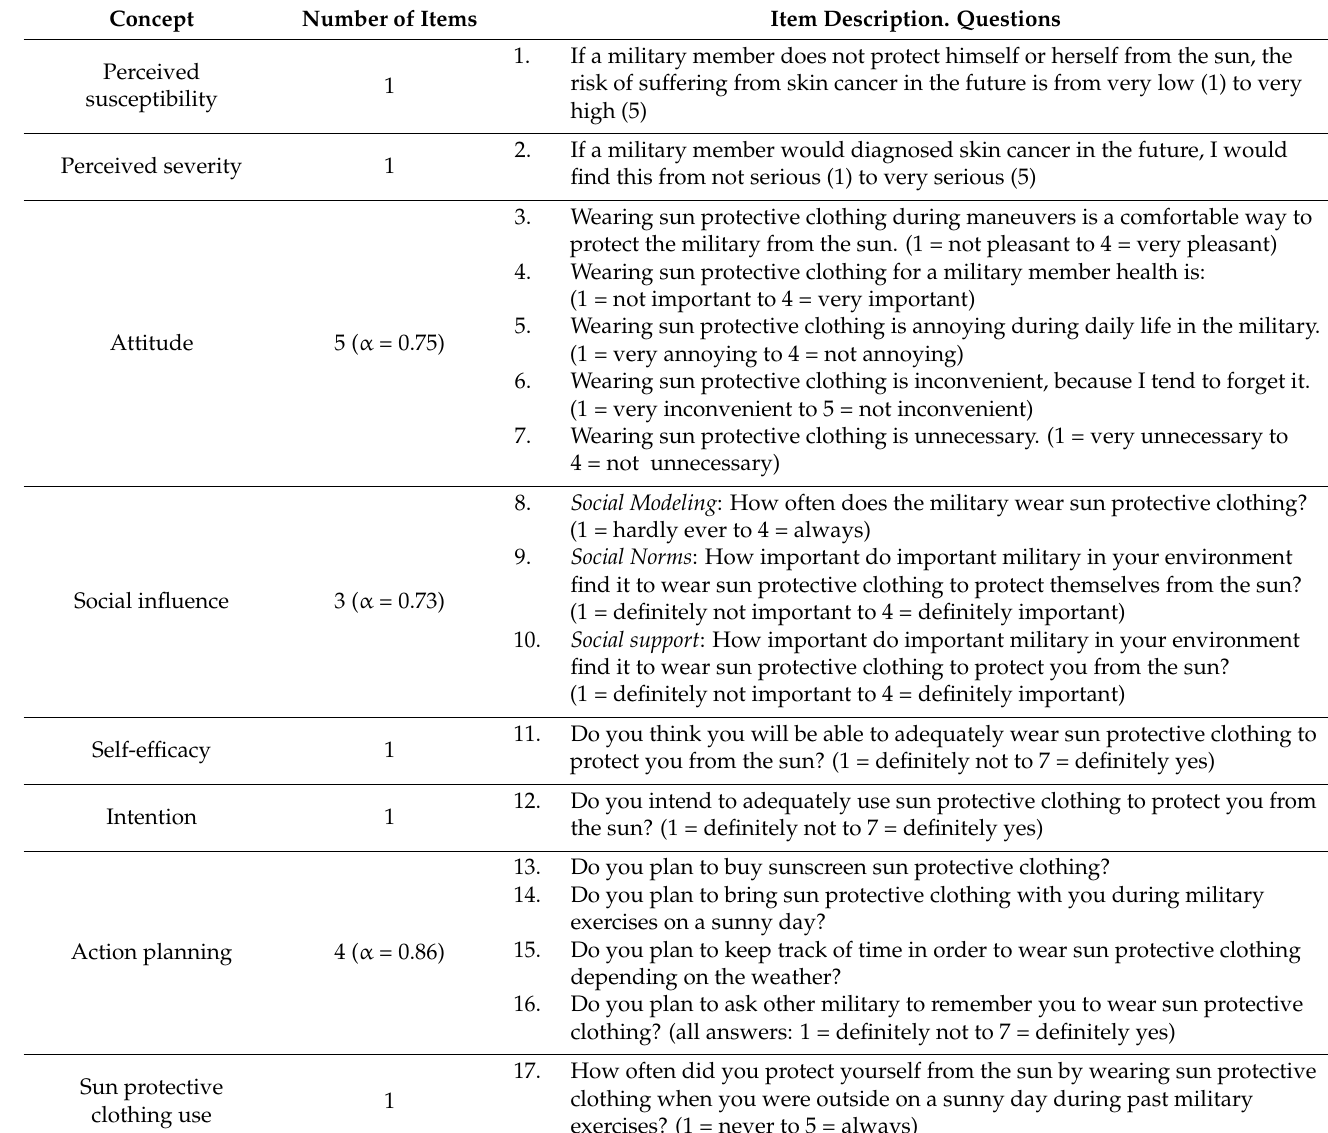
Table 1. Description of the measurement of cognitive concepts and military sun protective clothing